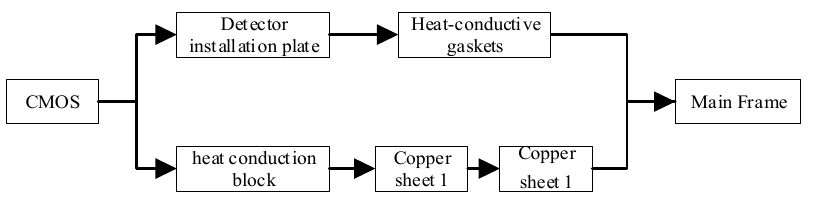
Figure 4. CMOS heat transfer path.